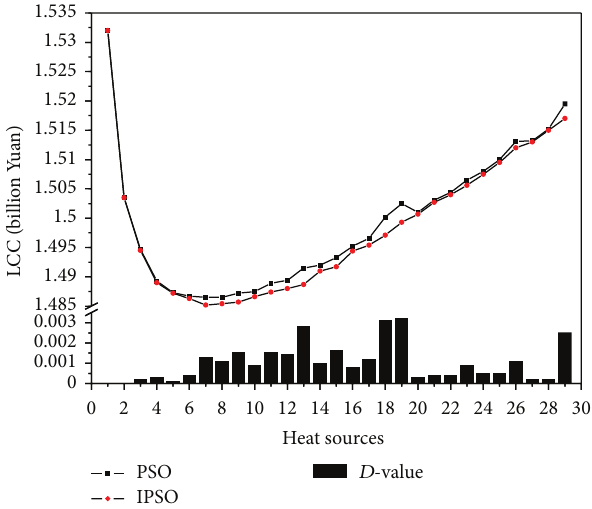
Figure6:Algorithmcalculationresultscomparison(averagevalue).